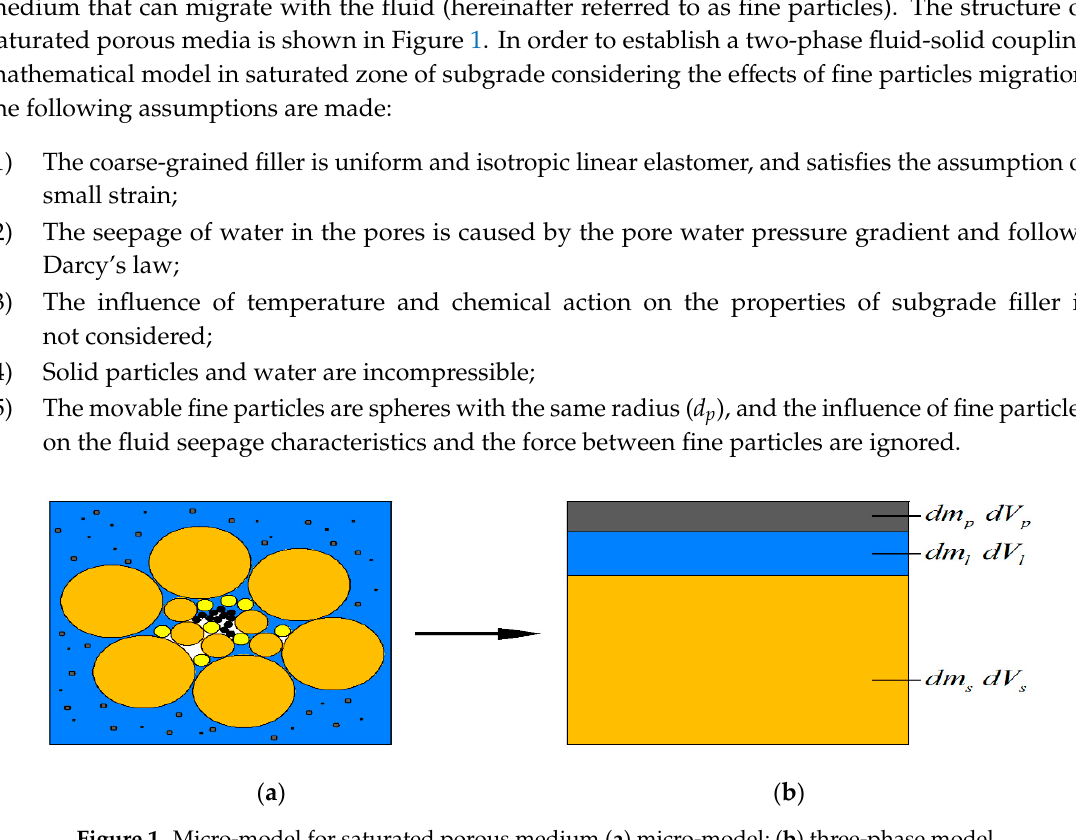
Figure 1. Micro-model for saturated porous medium ( a ) micro-model; ( b ) three-phase model.